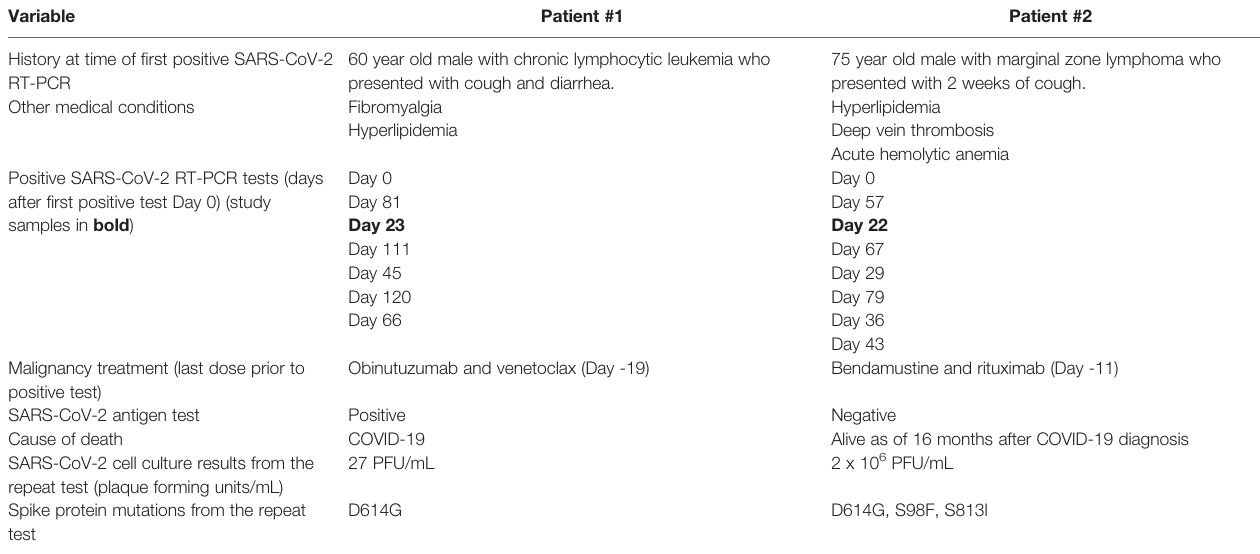
TABLE 2 | Characteristics of patients with a positive SARS-CoV-2 cell